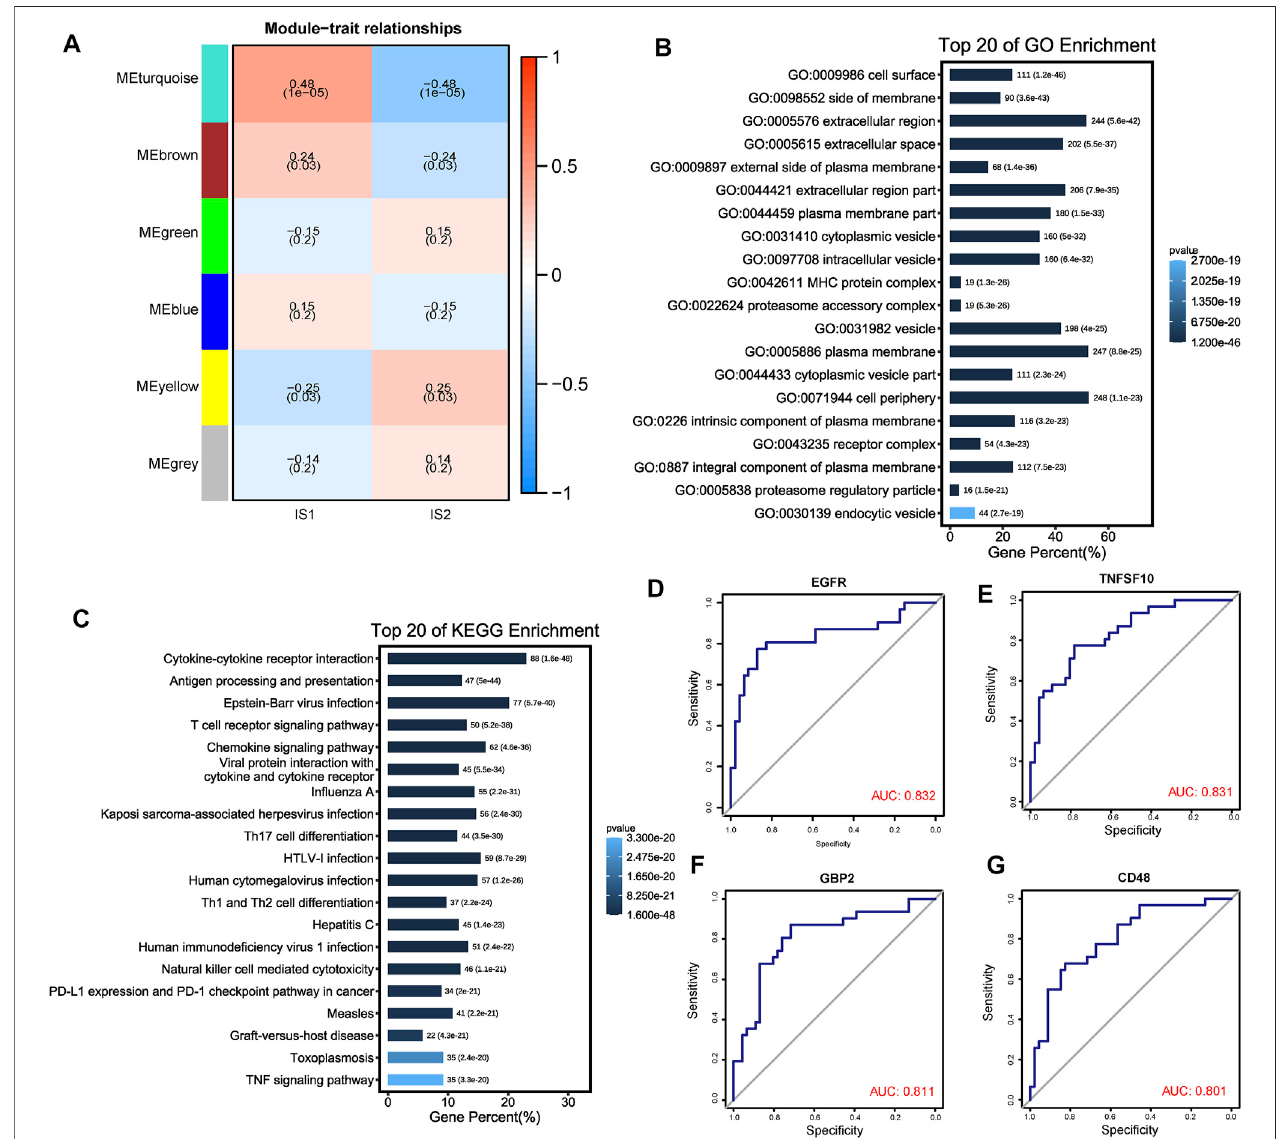
FIGURE 8 | Identi fi cation of immune gene co-expression modules of ESCC. (A) Heatmap showing the relationship between the gene module eigenvalues and different immune subtypes. The number above each model represent correlations, numbers below represent p value. (B, C) Top 20 GO and KEGG enriched functions and pathways of “ MEturquoise ” module genes. (D – G) ROC plots showed the four genes with a suitable predictive ability for the prognosis with AUC > 0.8.